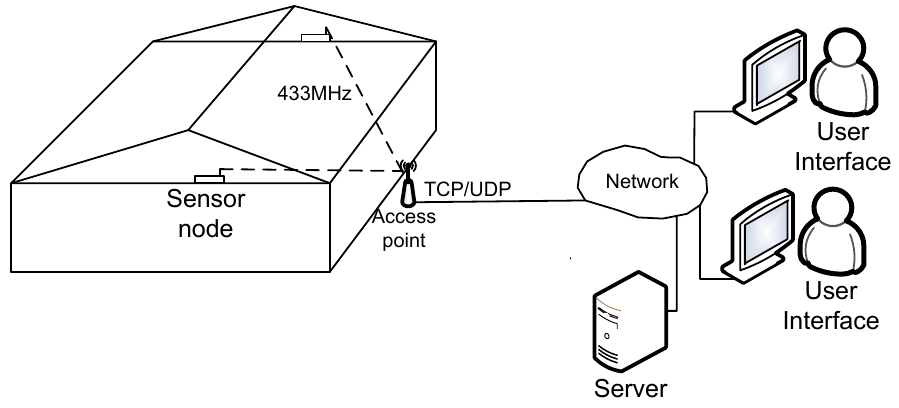
Figure 2. Schematic structure of system for monitoring load of the roof.